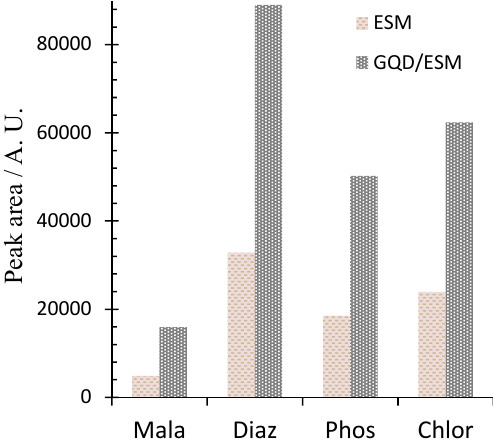
Fig. 2: Comparative chromatographic responses observed for OPPs after preconcentration by ESM and GQDs/ESM as sorbents. Conditions: adsorbent amount: 100 mg; sample volume: 150 mL; concentration of each analyte: 100 ng mL −1 ; flow rate: 2 mL min −1 ; desorption solvent: acetonitrile; NaCl concentration: 200 mM; pH =